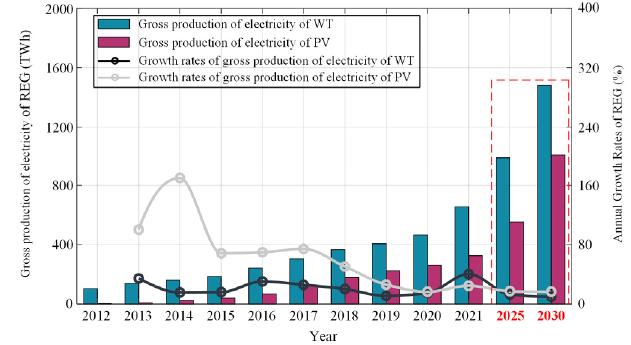
Figure 3. Installed capacity of WT and PV in China.